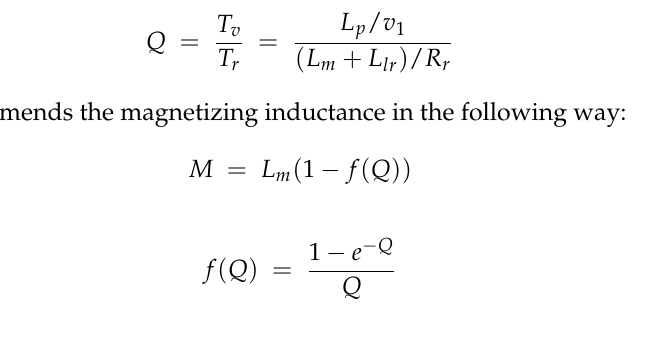
Figure 2. Normalized air-gap flux density versus time.